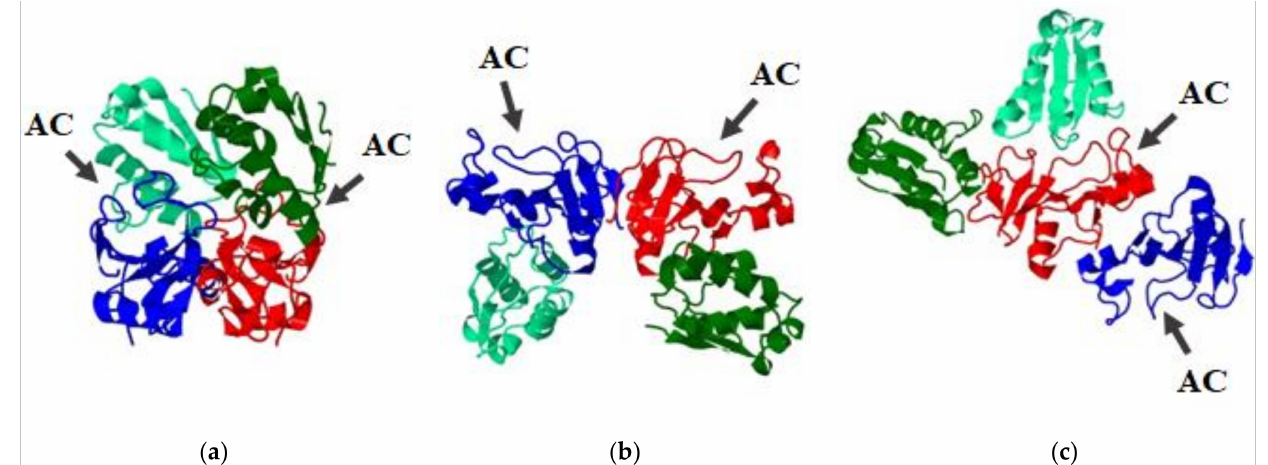
Figure 7. Models of barstar interaction with RNase dimers. ( a ) Barnase dimer; ( b ) balifase dimer; ( c ) binase dimer. Monomers of RNase dimers are colored in blue and red. Their active sites are faced upwards (except for the monomer of binase colored in blue). Two molecules of barstar are depicted in light and dark green. Active centers (AC) of RNases are marked by